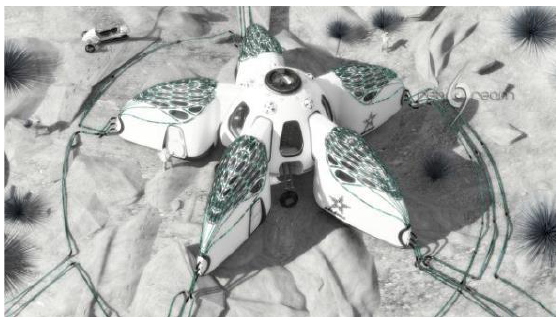
Fig. 2. Lunar power plant